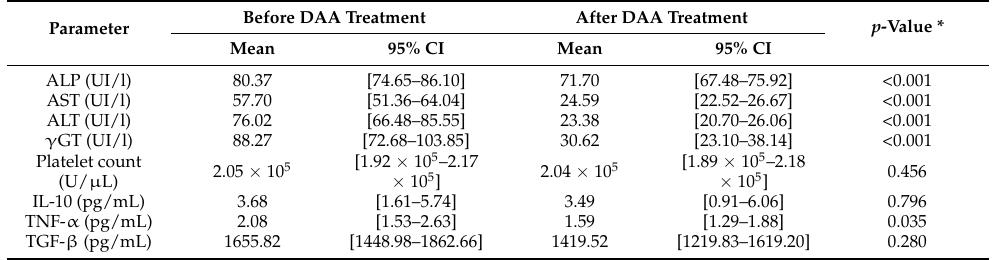
Table 5. Biochemical and cellular parameters before and after DAA treatment (continuous variables).